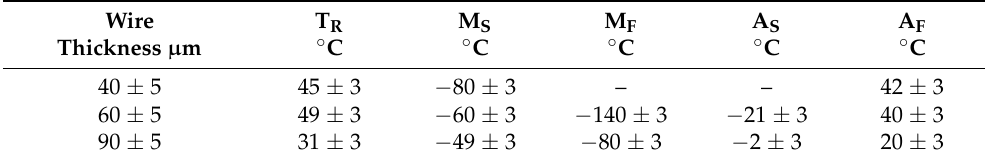
Table 3. The characteristic temperatures of martensitic transformations in NiTi samples.